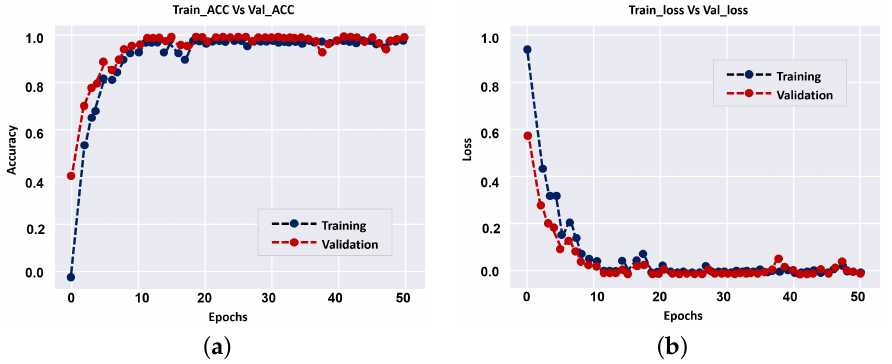
Figure 7. Progression of training and validation set accuracy ( a ) and loss ( b ) during network training.